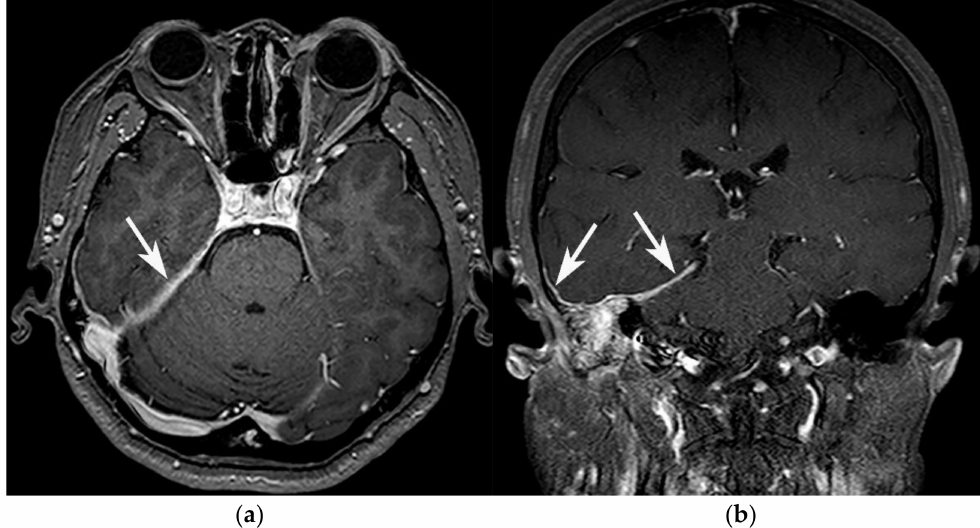
Figure 2. Dural involvement in a 54-year-old female patient diagnosed with GPA. ( a ) Axial, and ( b ) coronal contrast- enhanced T1WI show enhancing dural thickening at right temporal convexity and right tentorium